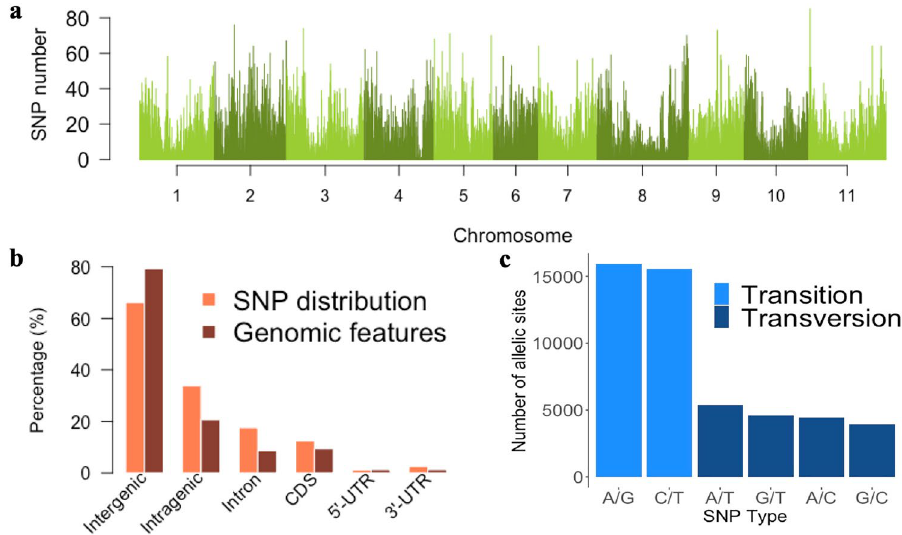
Figure 1. Identification and annotation of 49,817 single nucleotide polymorphisms (SNPs) obtained from the genotyping of 219 common bean accessions. ( a ) Distribution of SNP density along the common bean genome in